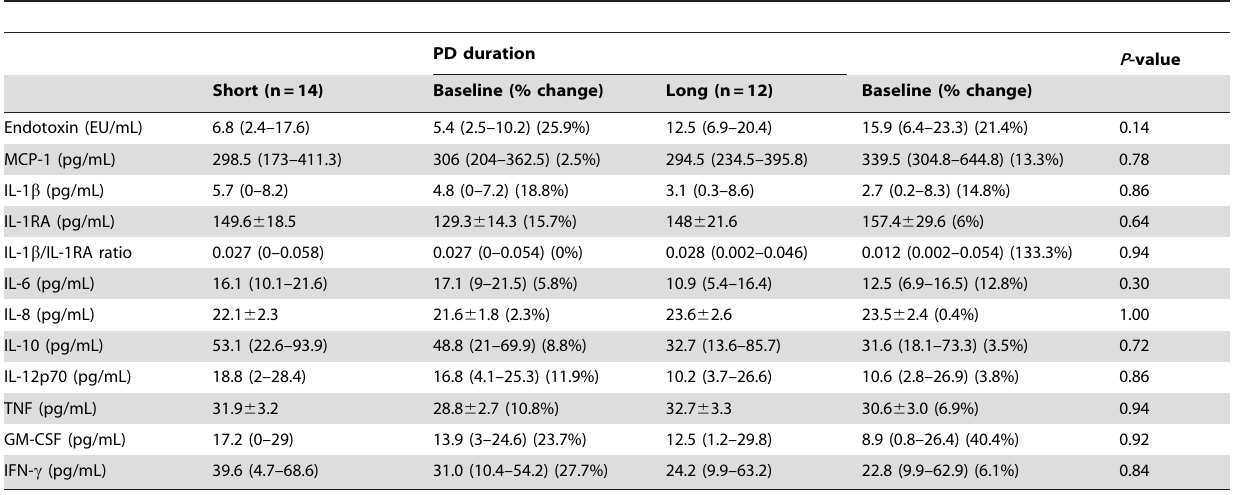
Table 5. Comparison of circulating endotoxin and cytokine levels after a 4-h exchange between the short- and long-term PD